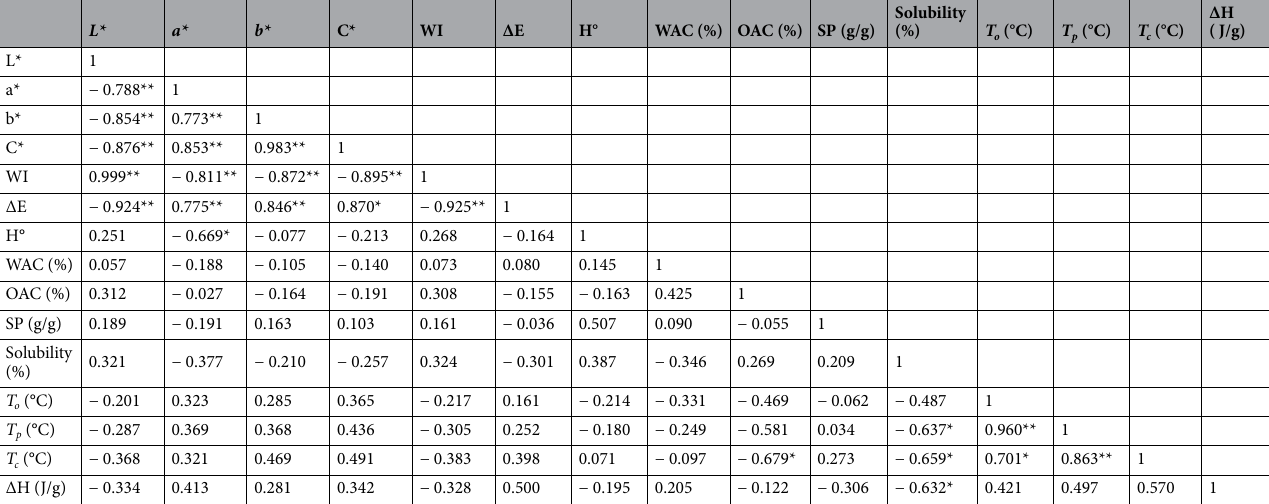
Table 11. Correlation matrix of colour, functional and thermal properties of HMT 25 Bambara groundnut starch. WAC: water absorption capacity; OAC: oil absorption capacity; SP: swelling power; ∆H: gelatinization enthalpy; ∆E: total colour difference, WI: whiteness index; L* : lightness/whiteness; a* : yellowness/redness; b* : blueness/greenness; C*: chroma; H°: hue; T o : onset temperature; T p : peak temperature; T c : conclusion temperature; ∆H: gelatinization enthalpy. **Correlation is significant at the 0.01 level; *Correlation is significant at 0.05